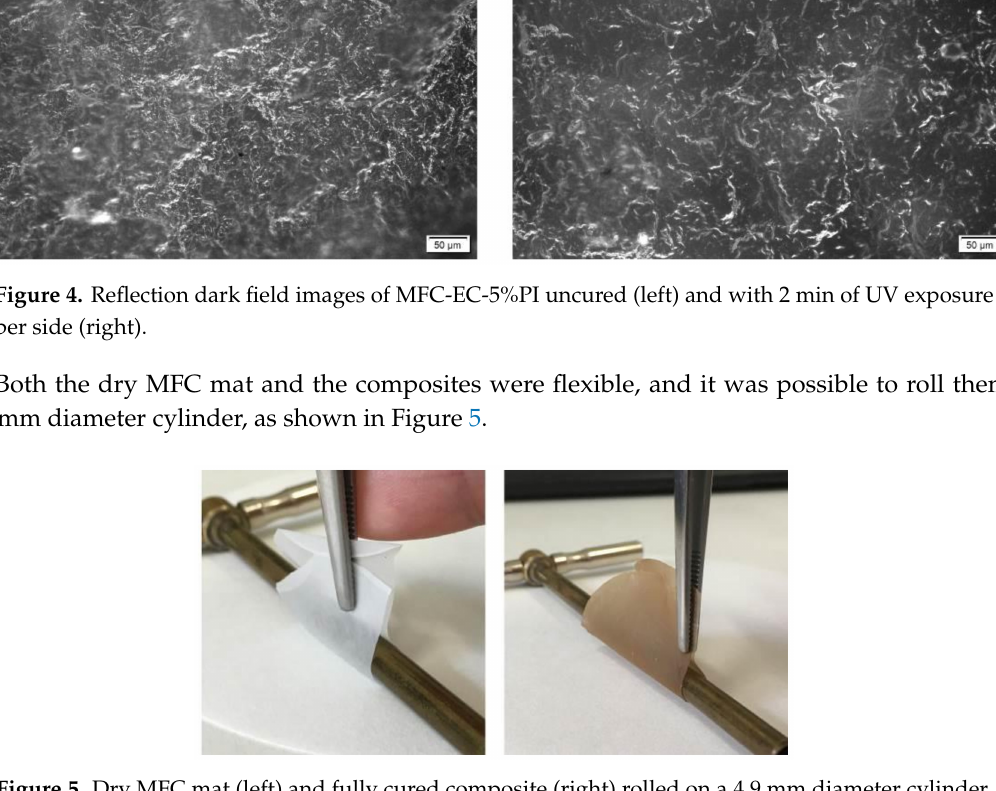
Figure 5. Dry MFC mat (left) and fully cured composite (right) rolled on a 4.9 mm diameter cylinder.